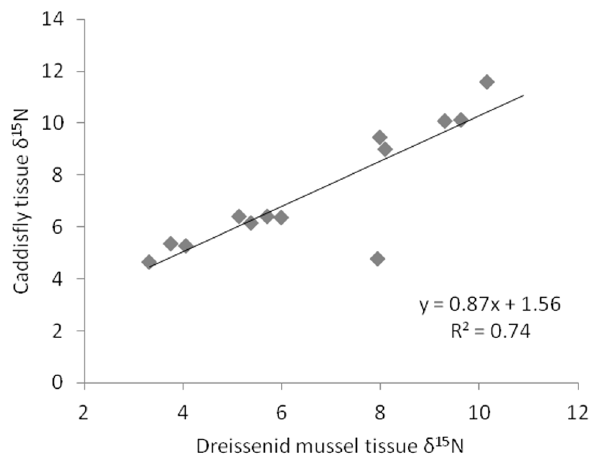
Figure 2. Relationship between caddisfly and dreissenid mussel tissue d 15 N. Each point represents a location where both